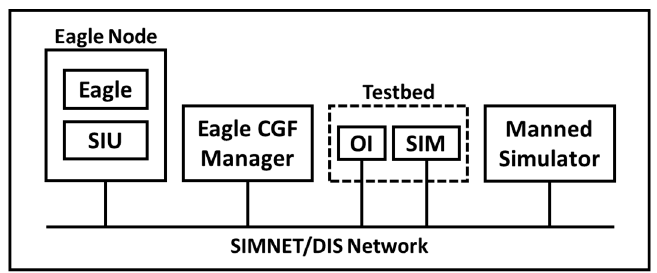
Figure 5. Integrated Eagle/BDS-D Network Configuration (adapted from [33,34]).